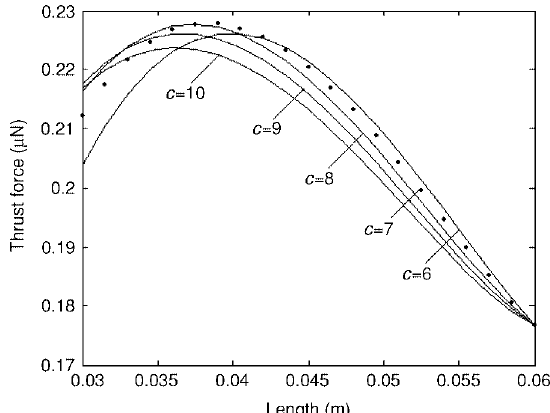
Figure 9 Propulsion diagram when b = 0.03 and c ∈ [6 , 10].